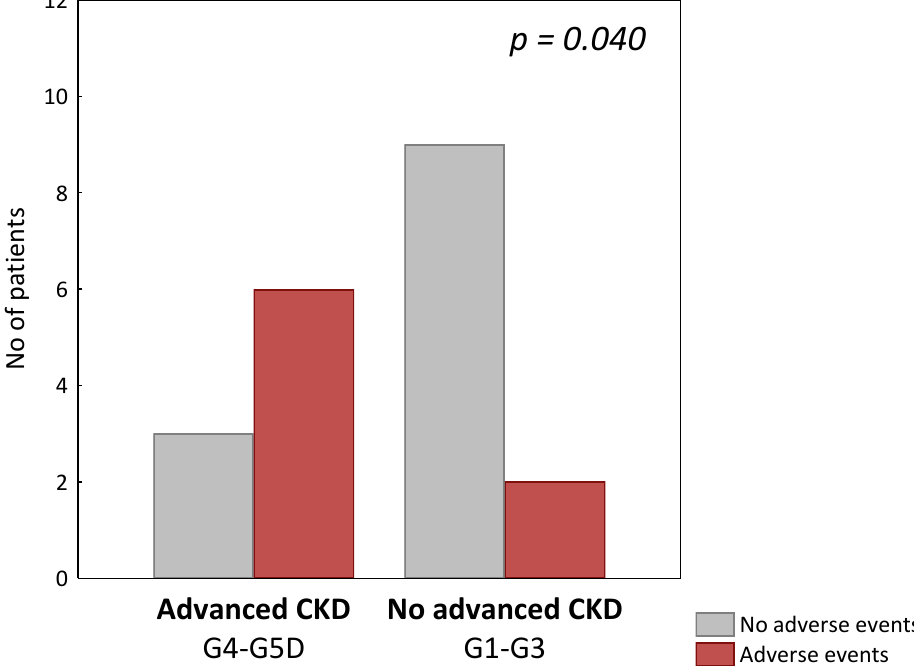
Figure 2. RTX-related adverse events in patients with and without advanced chronic kidney disease (CKD).